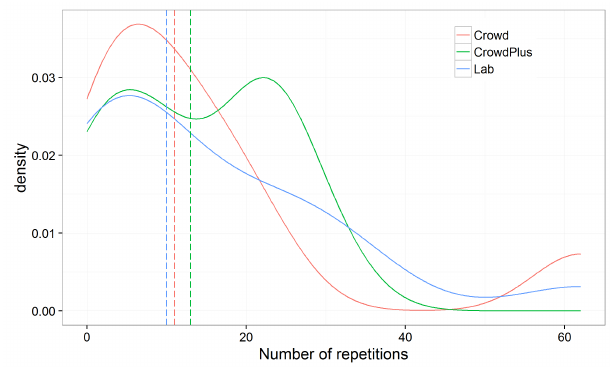
Figure 7. Estimated density of repetitions of complete rounds played by group along with group medians as vertical dashed lines